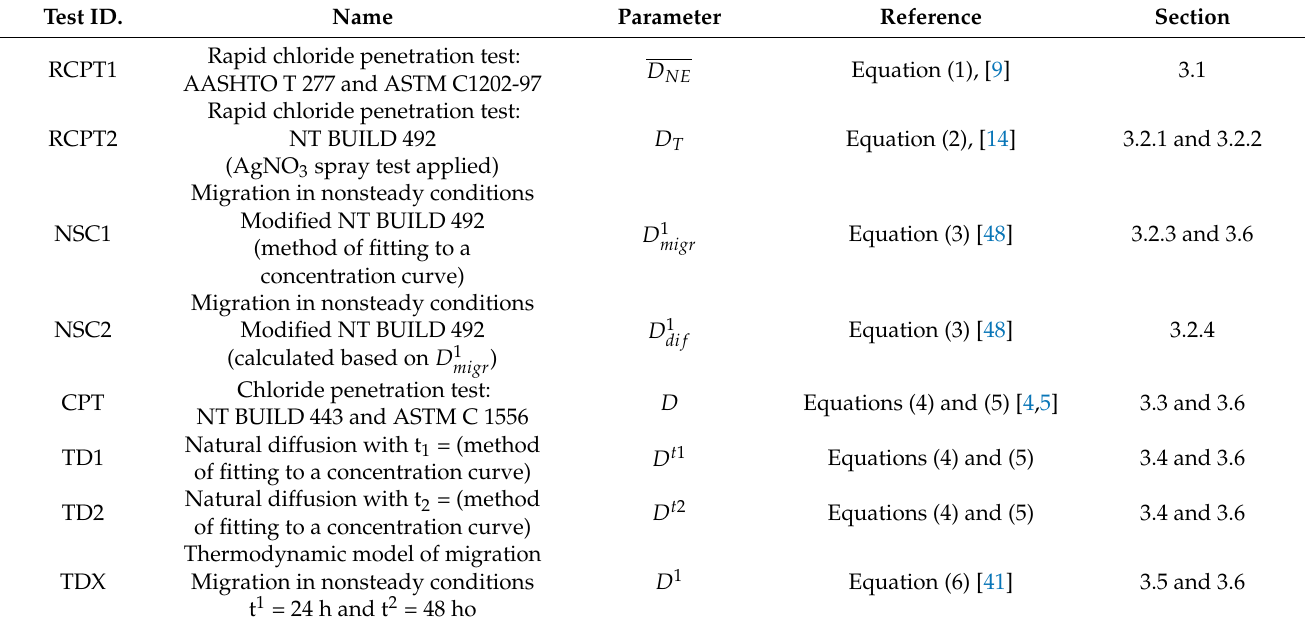
Table 4. Overview of performed test